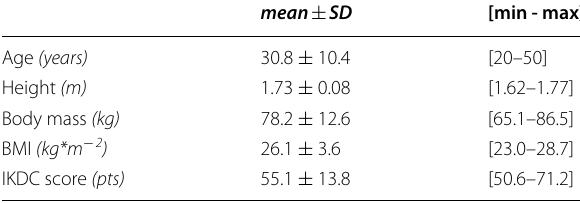
Table 1 Basal demographic characteristics of the